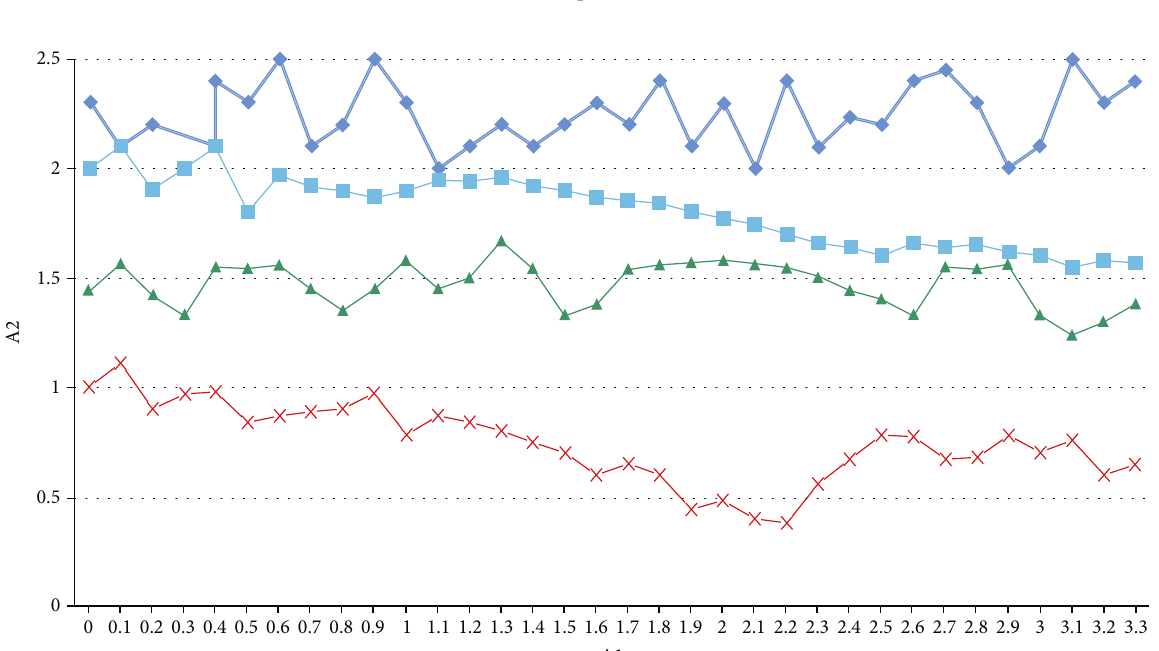
Figure 3: The process of GA.